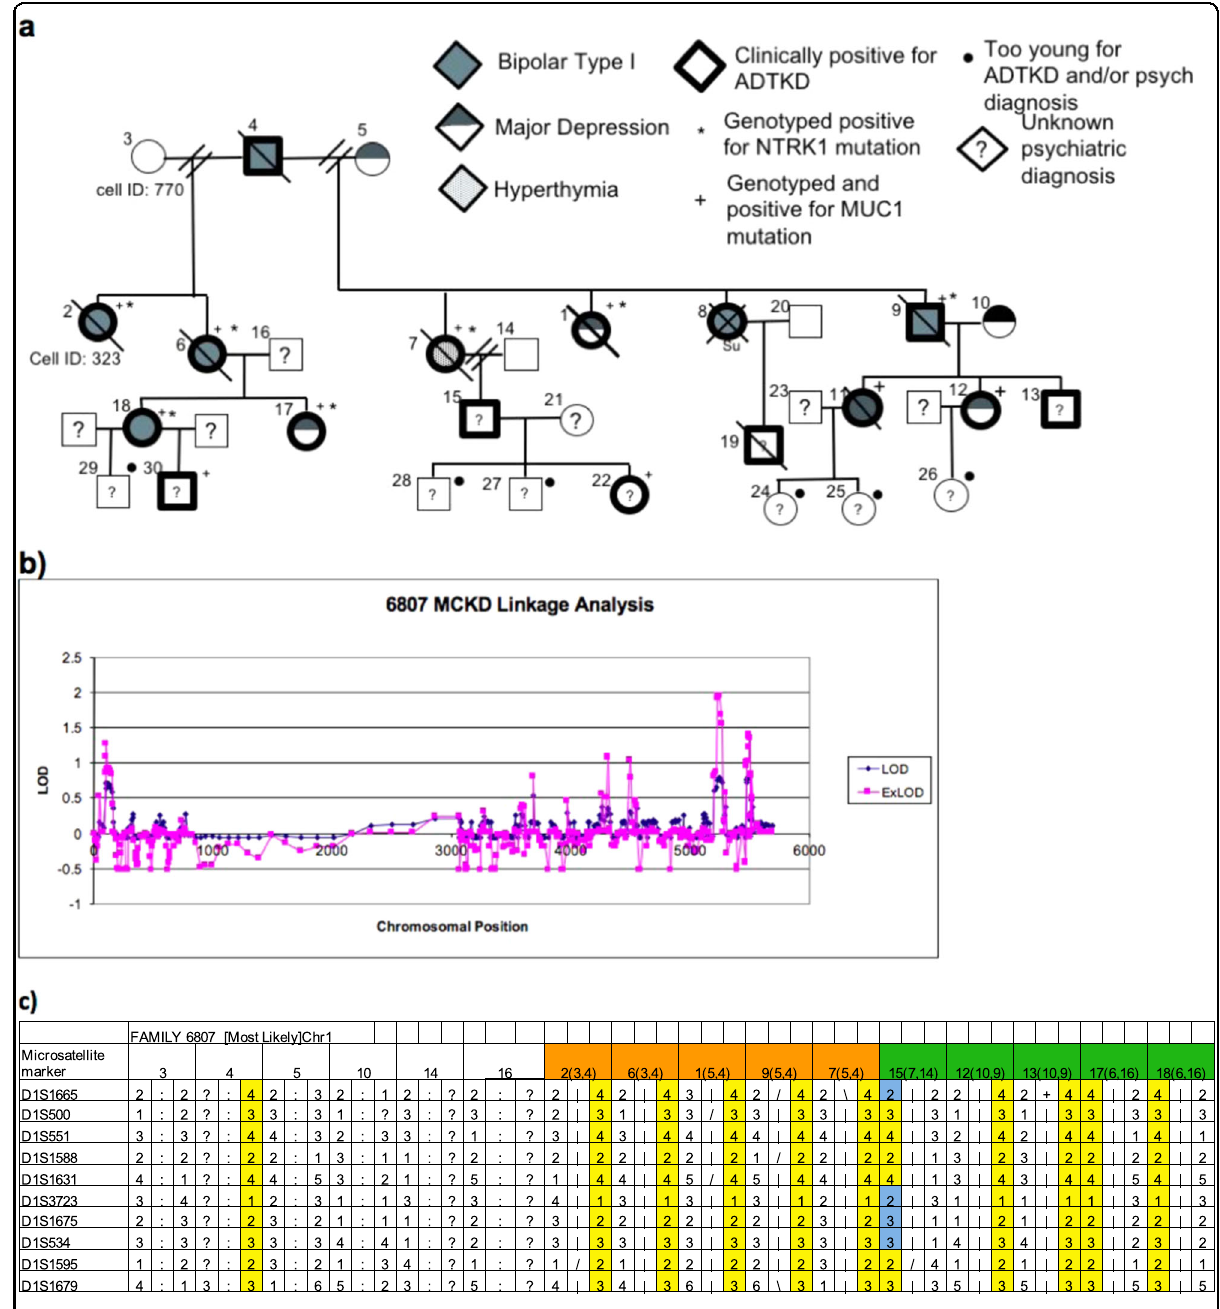
Fig. 1 Identi fi cation of NTRK1 mutation. a The pedigree of family 6807. b Linkage analysis plot for family 6807. c Microsatellite markers for chromosome 1, including NTRK1 region. Haplotypes for. available members of the family (orange indicates 2nd generation, green indicates 3rd generation) and inferred haplotype for 1st generation father. Yellow columns indicate regions of homozygosity and blue regions indicate recombination